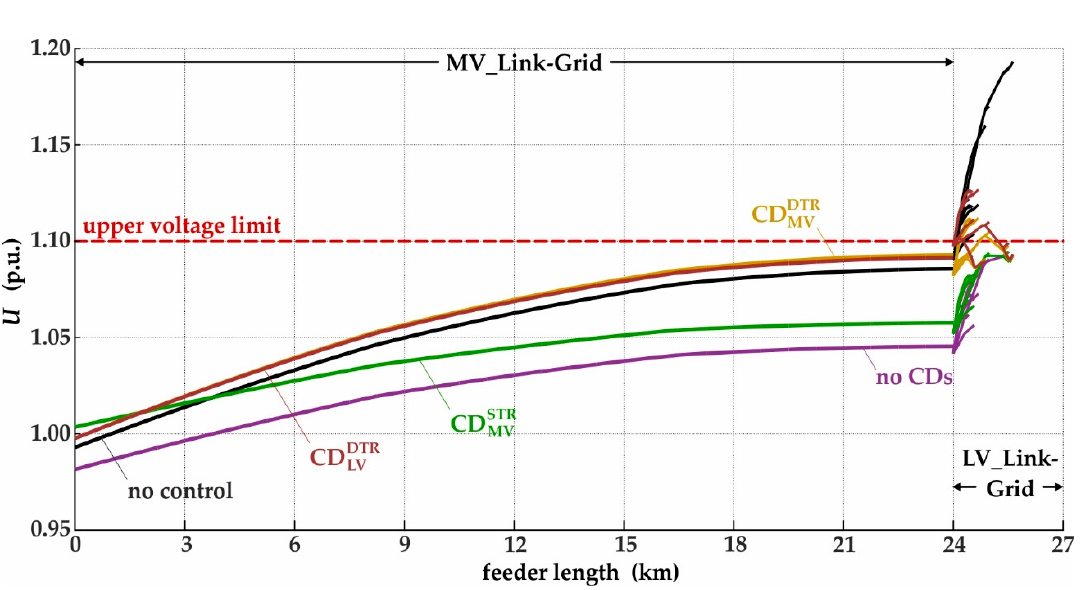
Figure 12. Voltage profile of the MV_link-grid with overhead line conductors and the backmost LV_link-grid at t = t crit .